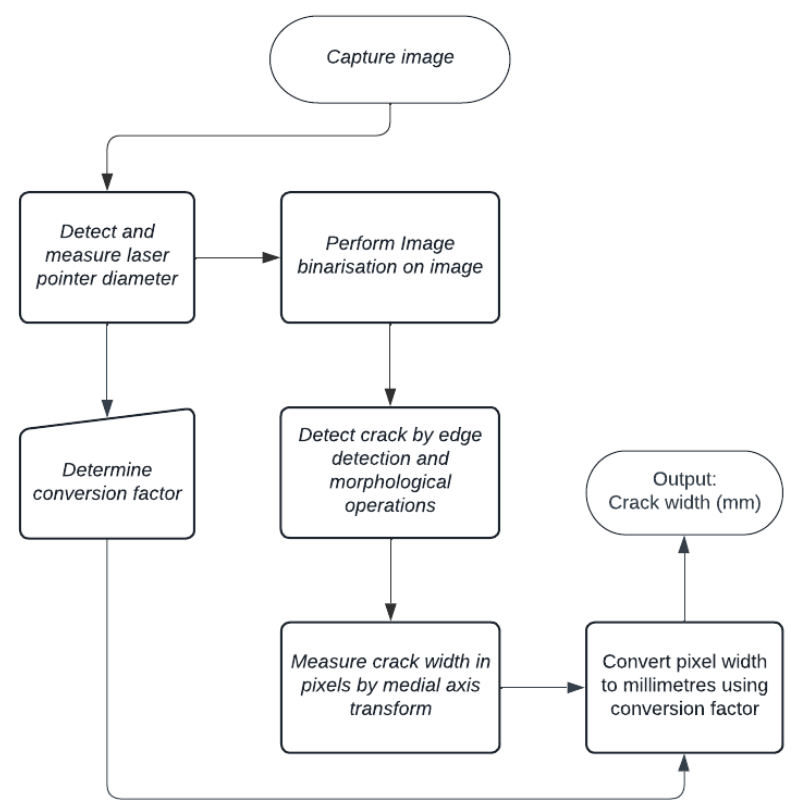
Figure 1. Flowchart showing the crack width measurement process.